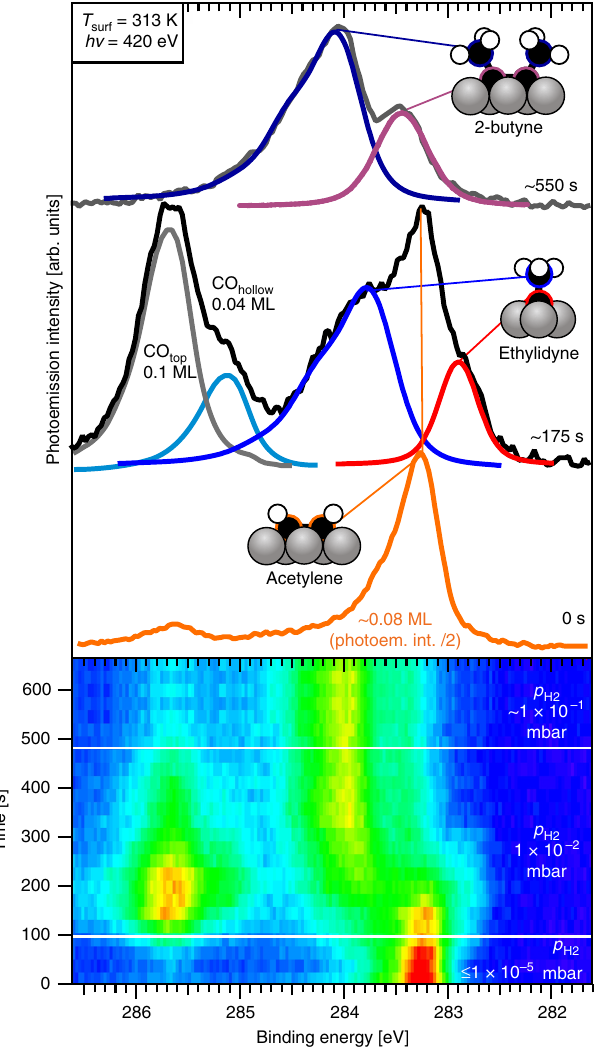
Fig. 4 XPS at near-ambient pressures. C 1s spectra recorded during exposure of an acetylene-covered Co(0001) surface to increasingly high H 2 pressures at T = 313 K. The time evolution of the C 1s spectra is shown in the lower panel, whereas the top view shows the spectra at speci fi c stages of the experiment (h ν = 420 eV). Note that the signal intensity of the acetylene spectrum in the upper panel was divided by two to facilitate comparison.